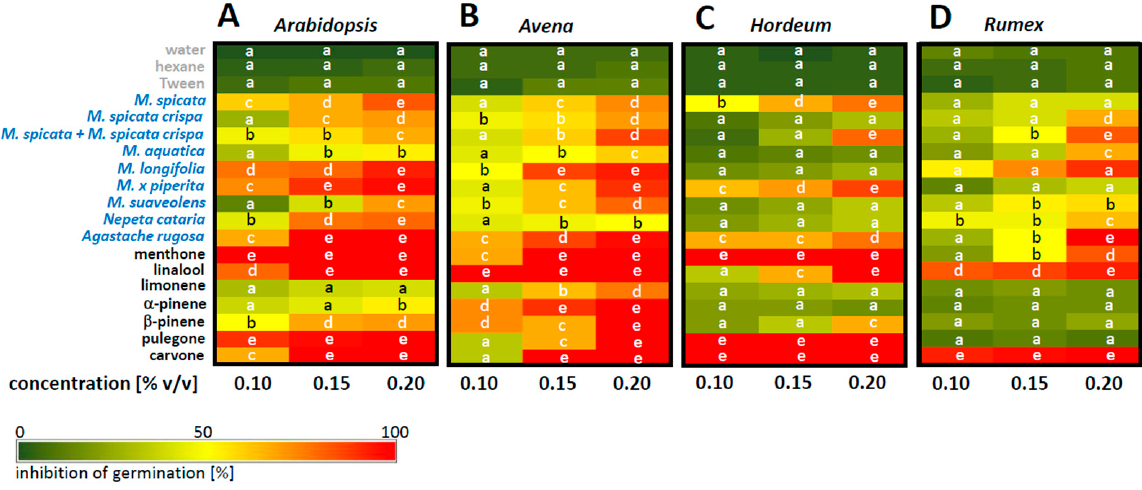
Figure 4. Species spectrum of sensitivity to essential oils from different mints and of compounds found therein administered through the liquid phase. Inhibition of germination rate; mean values from three independent replications with 30 individuals scored for each experiment. Responses are shown for Arabidopsis thaliana ( A ), Avena sativa ( B ), Hordeum vulgare ( C ), and Rumex acetosella ( D ). Solvent controls involve 0.15% hexane (as solvent for the pure compounds), 1% v / v Tween 20 (as solvent for the essential oils, blue), or water. Letters indicate groups that are different with respect to the Least Significant Difference (LSD) test for a significance threshold of p < 0.05.